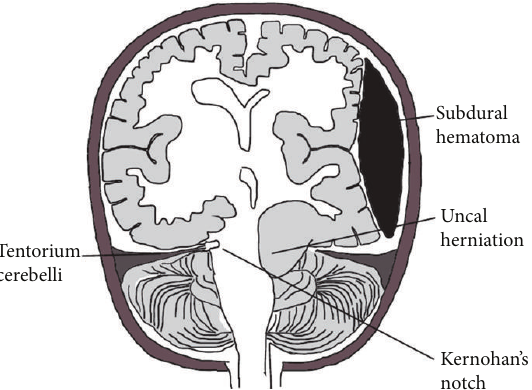
Figure 3: Schematic representation of Kernohan’s notch. Demon- strated here are a subdural hematoma and uncal herniation on the same side. Notching of the midbrain is seen on the opposite side (Kernohan’s notch). This damages the contralateral pyramidal tract fibersinthemidbrainandcauseshemiparesisonthesideofsubdural